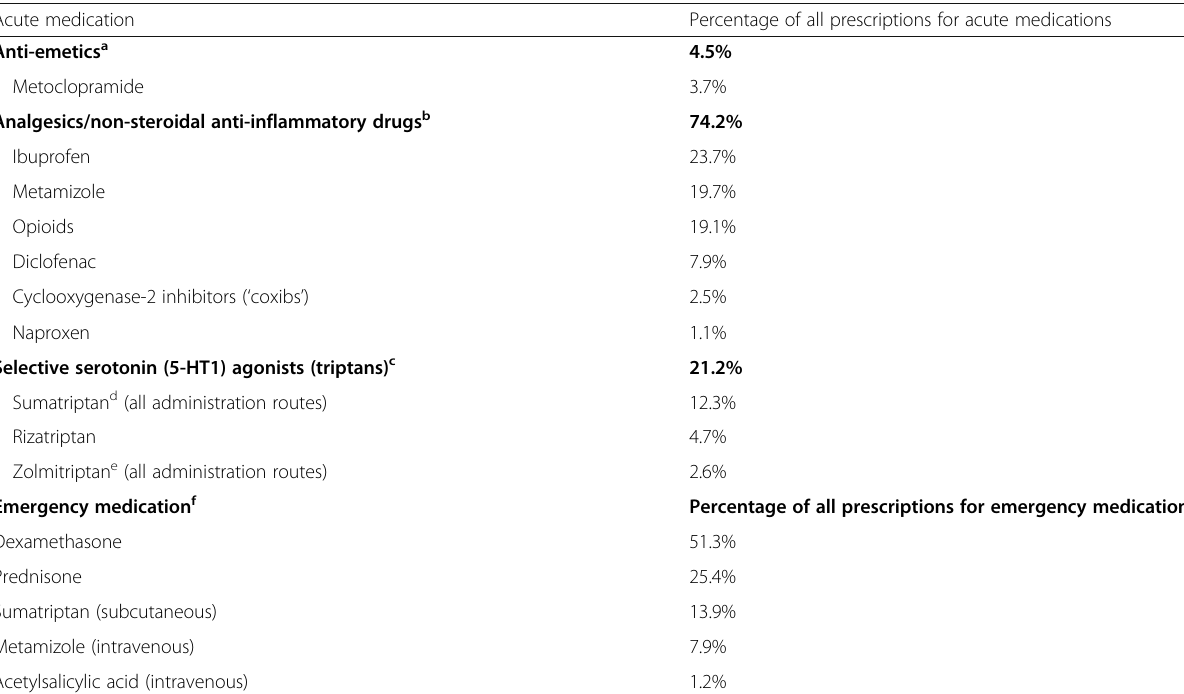
Table 5 Prescribed acute and emergency medications for patients with migraine in the German Company Sickness Fund